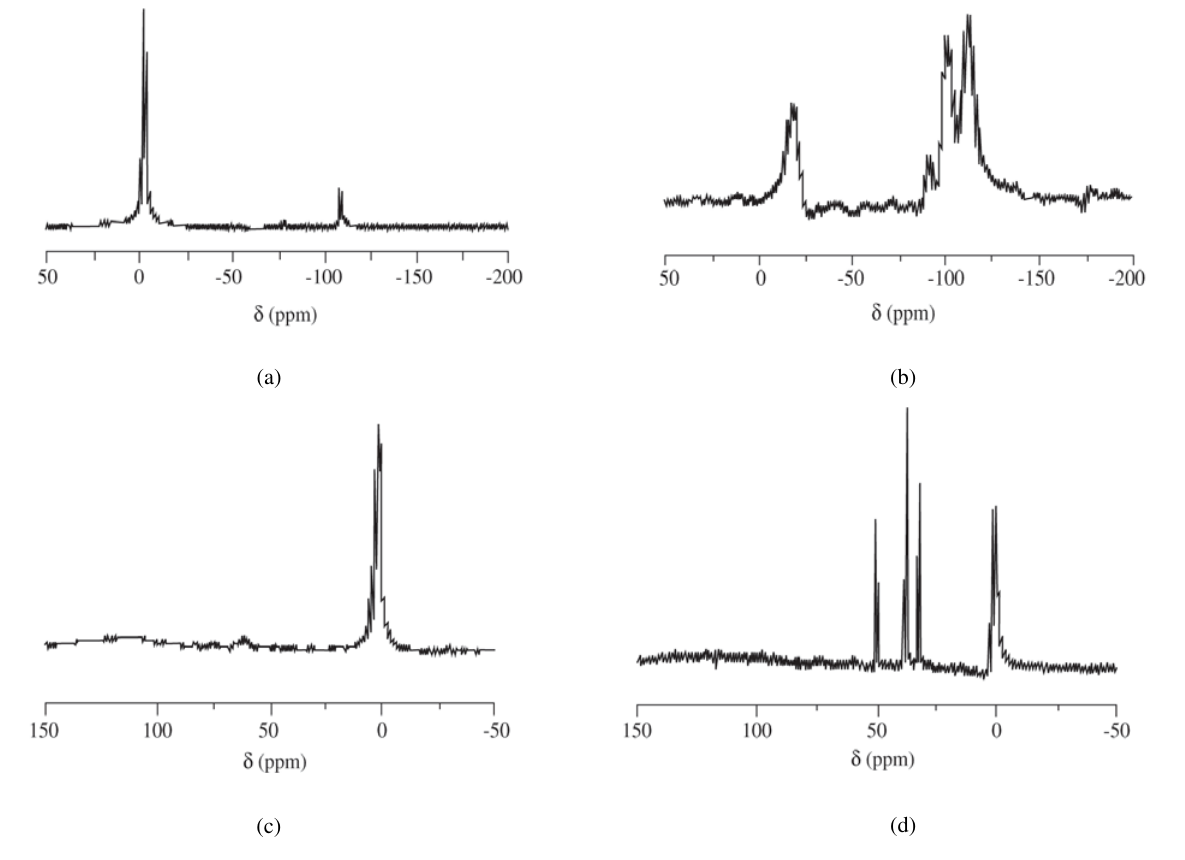
Figure 3. 29 Si NMR solide state for : a) cubes; b) octakis (chloropropyldimethylsiloxy) octasilsesquioxane; c) 13 C NMR solide state for: cubes; d) octakis